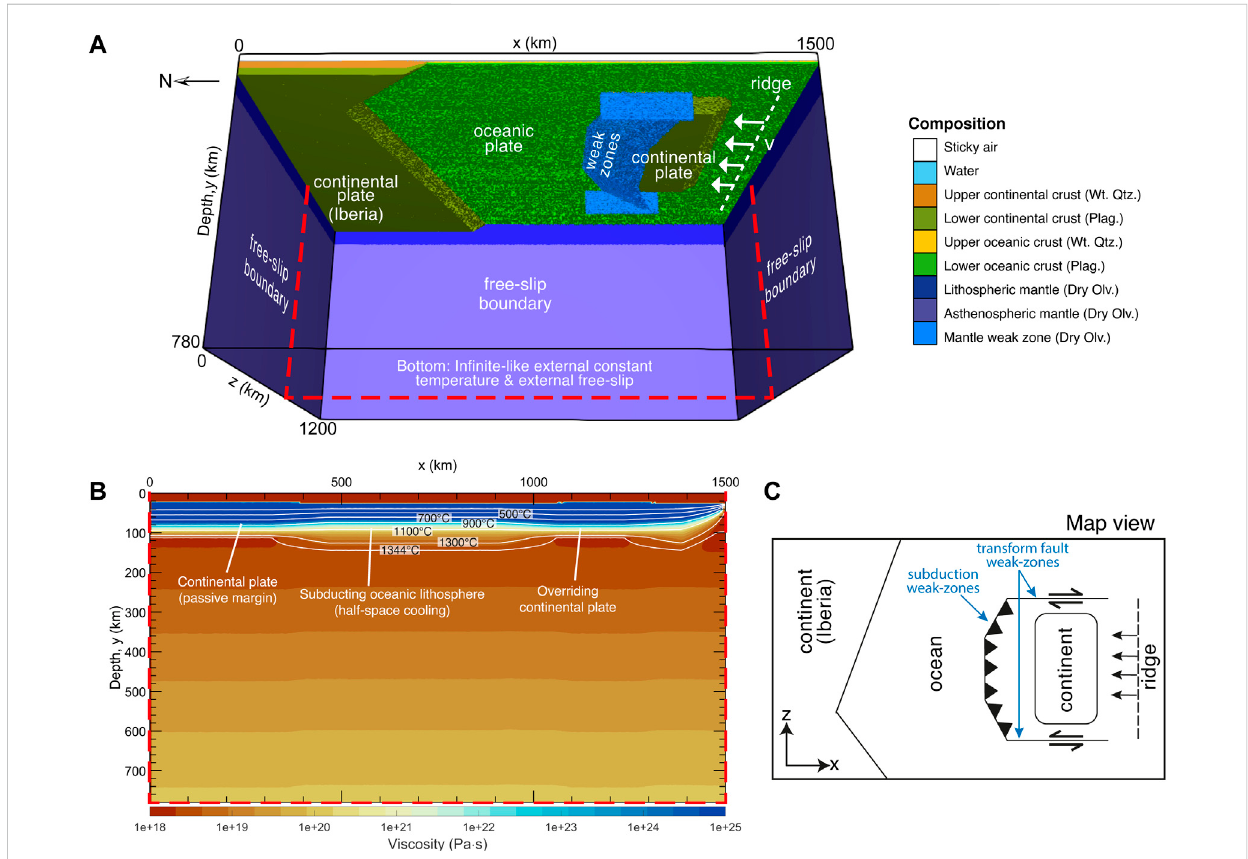
FIGURE 2 Setup of Mod1-reference model. (A) 3D model domain (1,500 × 780 × 1,200 km) with colours representing different compositions. The fl ow law abbreviations are Wt Qtz. — wet quartzite; Plag. – Plagioclase; and Dry Olv. — Dry Olivine. Convergence is imposed by applying a uniform velocity v of 47 mm yr -1 until the slab reaches 200 km depth. At that stage we set time as t = 0 and the block velocity v becomes controlled by the sinking slab. (B) Cross-section pro fi le of the viscosity. (C) Map view of the model set up showing the obliquity adopted between the subduction fault and the continental